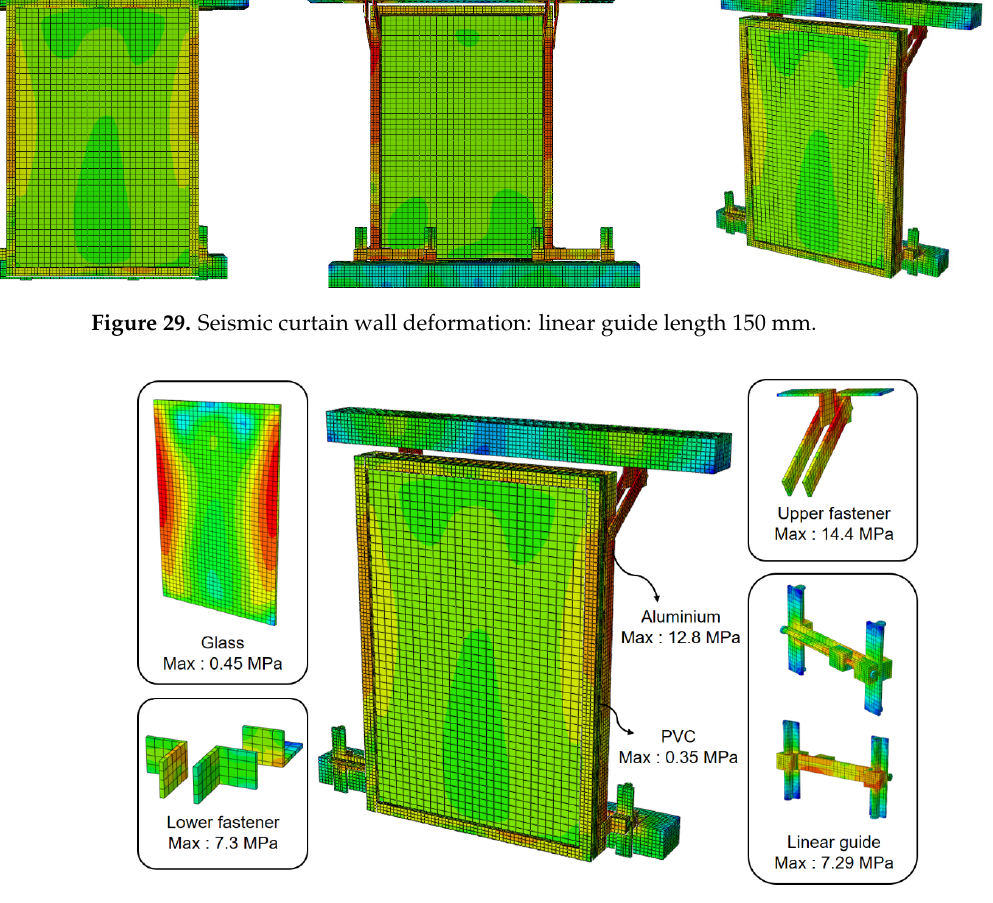
Figure 30. Stress distribution applied to each member: linear guide length 150 mm.